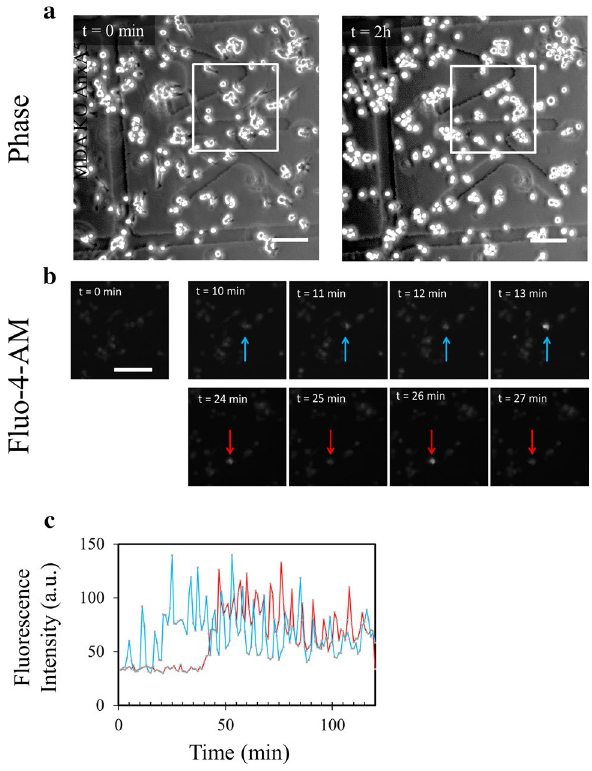
Figure 9. Highlighting un-resealed membrane damages in migrating AnxA5-AnxA6 deficient MDA-MB-231 cells. AnxA5-AnxA6 deficient MDA-MB-231 cells were treated as described in the legend of Fig. 3. ( a )